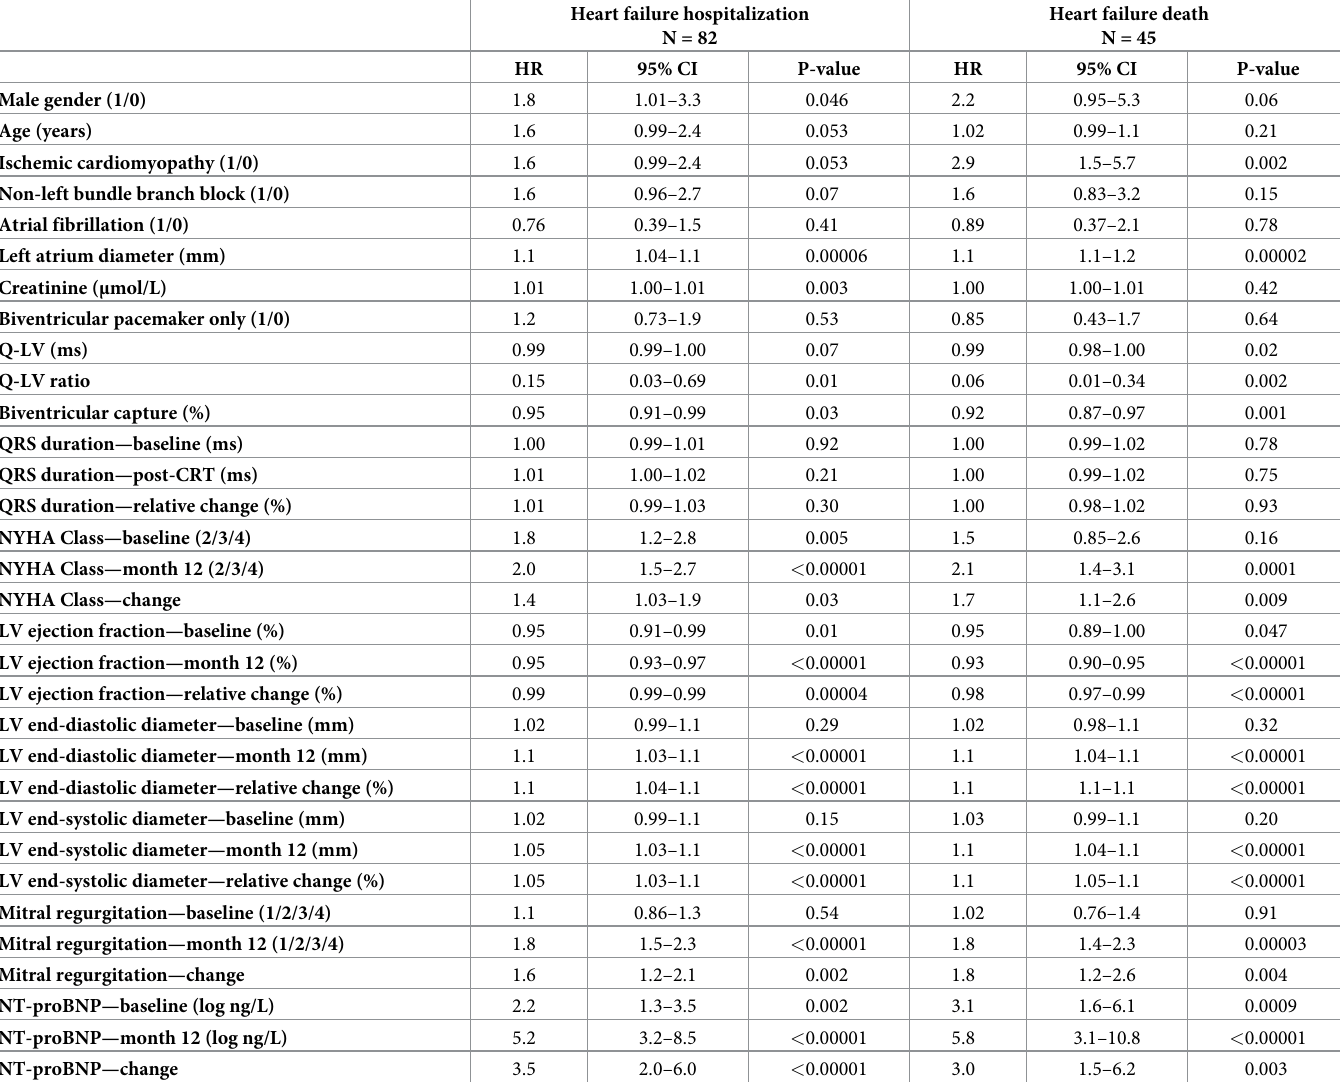
Table 2. Univariate association between individual factors and clinical events (hospitalization and death due to heart